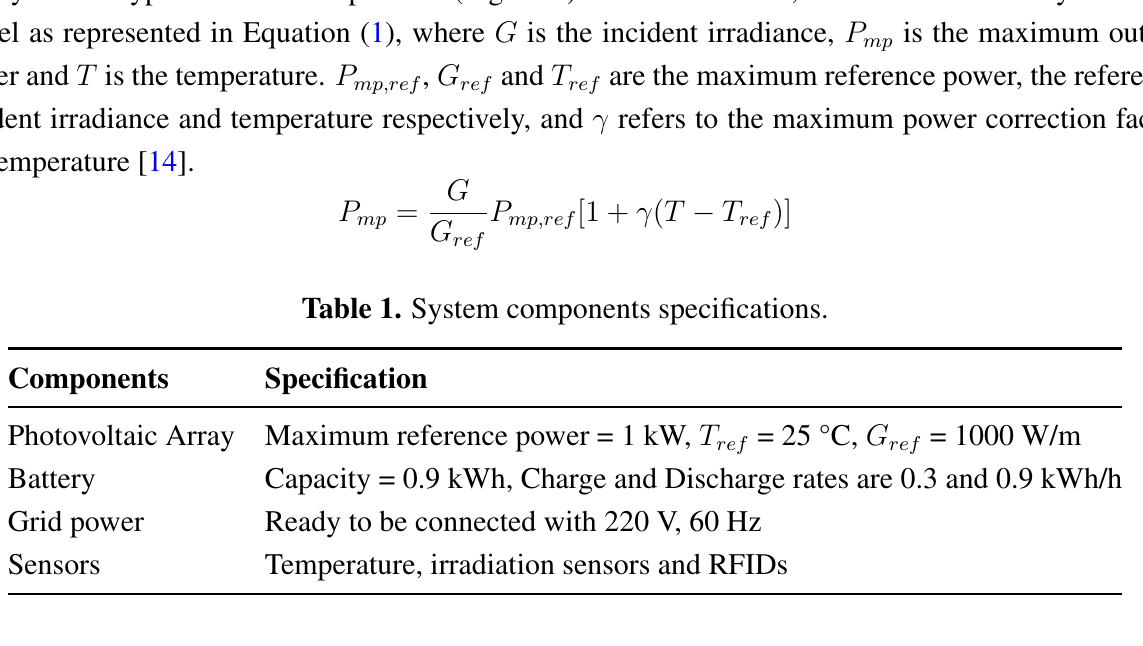
Figure 2. Sample of hourly electrical demand in